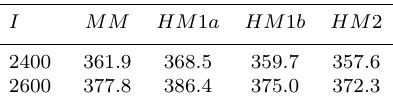
where A j = | Ω j | denotes the area of domain Ω j .